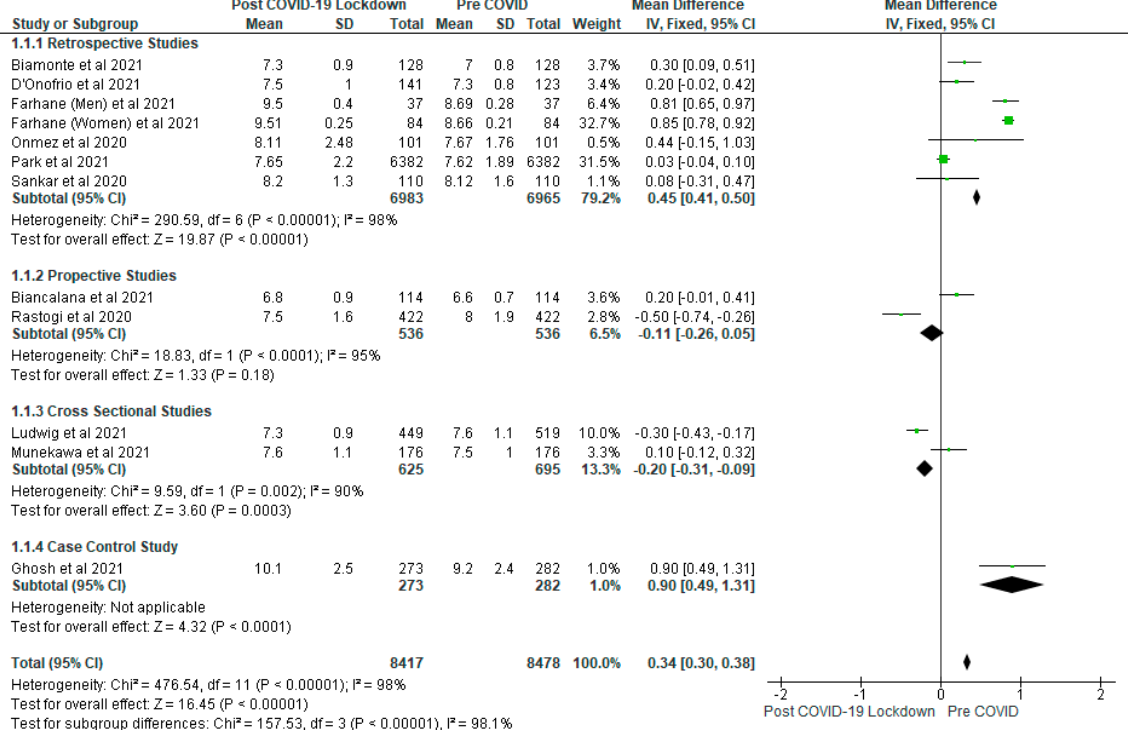
Figure 3. The effect of COVID-19 lockdown on Glycated Haemoglobin (%).